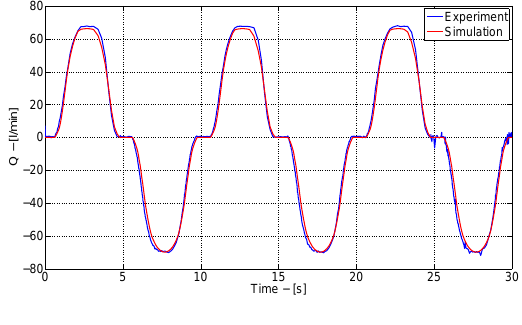
Figure 18: Comparison of simulated and measured valve flow at 0.1 Hz.